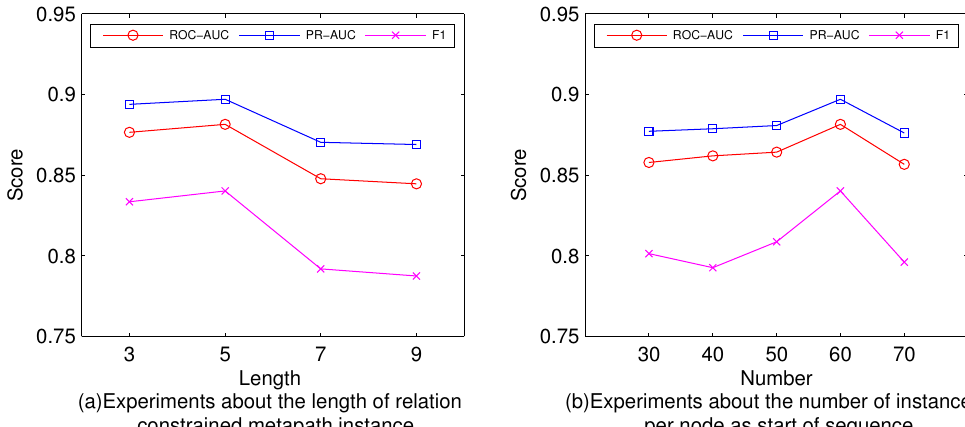
Figure 5. Parameters experiments of the Ali dataset.